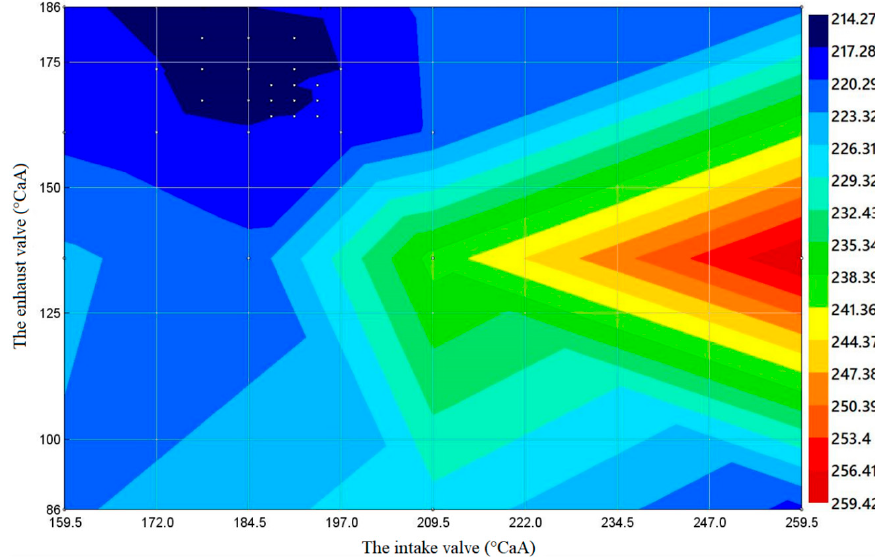
Figure 13. 50% load